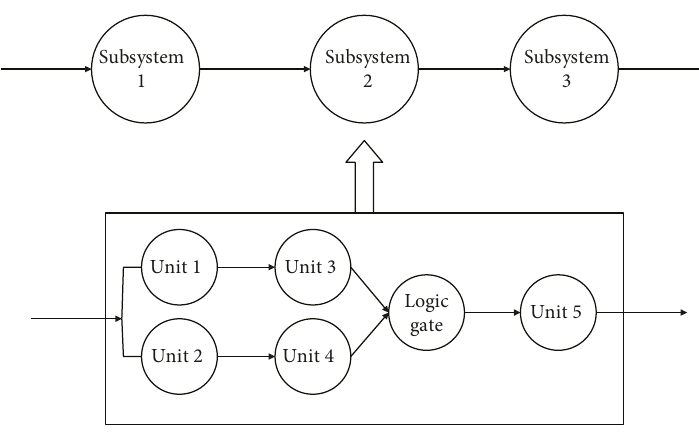
Figure 5: Hierarchical Table 2: Components of the models in the air braking system.